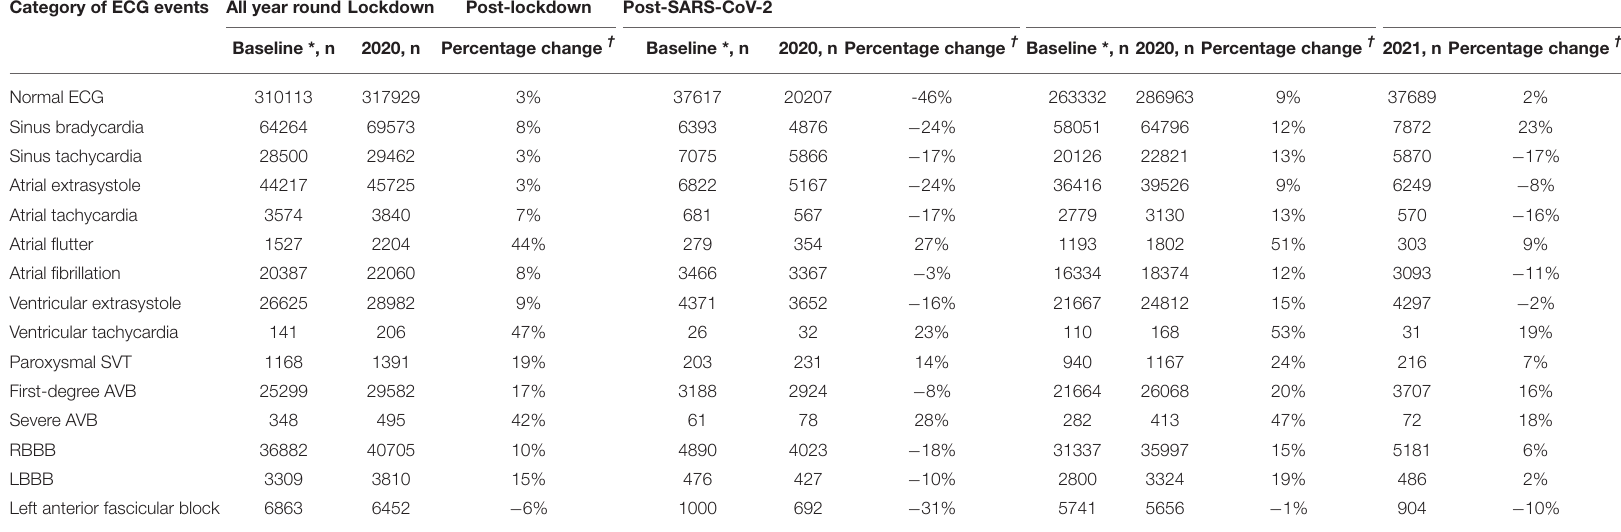
TABLE 2 | Dynamics of medical visits of various ECG events during different periods. Category of ECG events All year round Lockdown